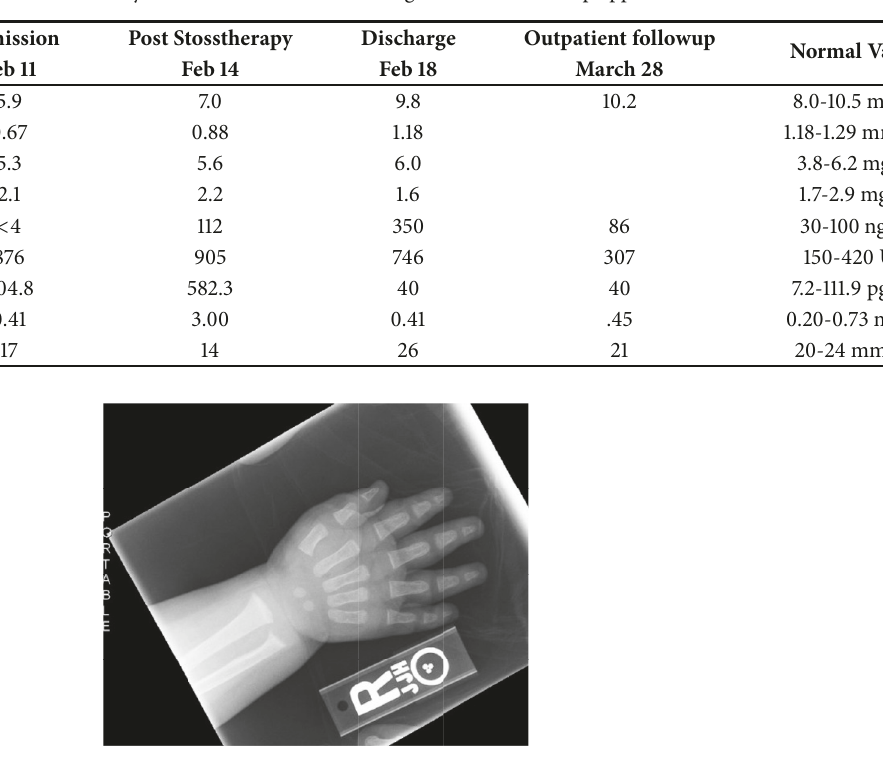
Table 1: Serial laboratory values from admission through six-week followup appointment.